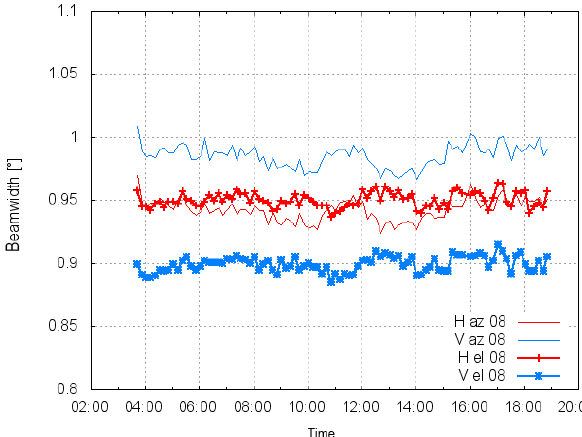
Figure 4. Time series (UTC) of 3dB beamwidths from 91 solar box scans. Data are taken on 23 June 2018. Shown are the beamwidths in vertical and horizontal dimensions and for horizontal and vertical polarizations.